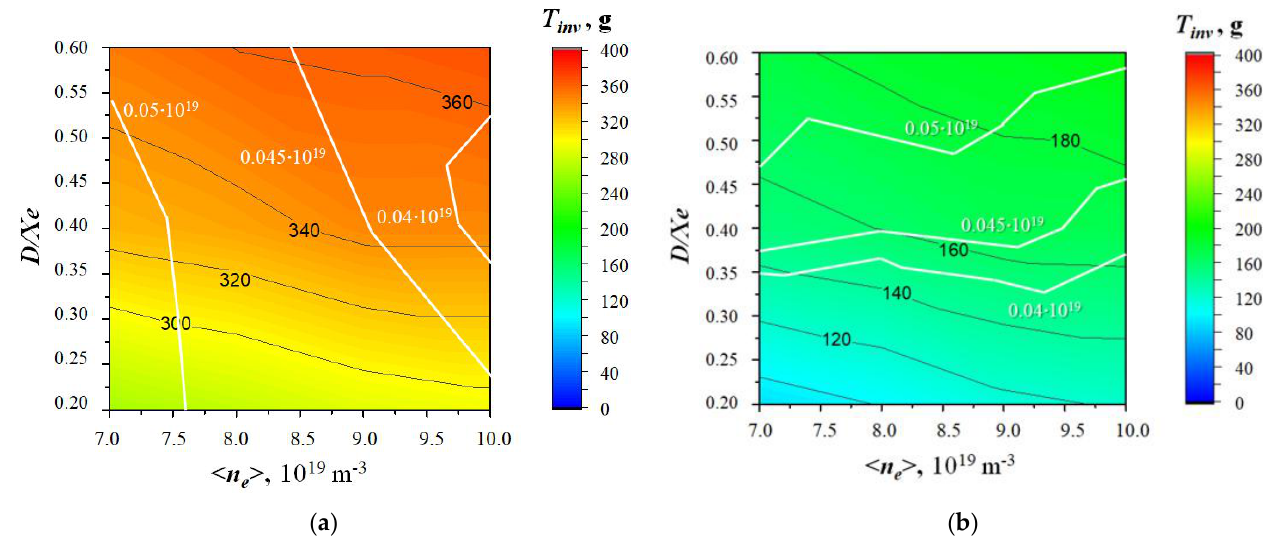
Figure 6. Amount of tritium at the site as a function of the n e and D/ χ e parameters for the ( a ) D+T and ( b ) D beams. The scale on the right shows the correspondence of the color and T inv values. The red lines are the level lines for the neutron flux S neut , shown in Figure 5, and the black lines refer to the accumulated tritium T inv .